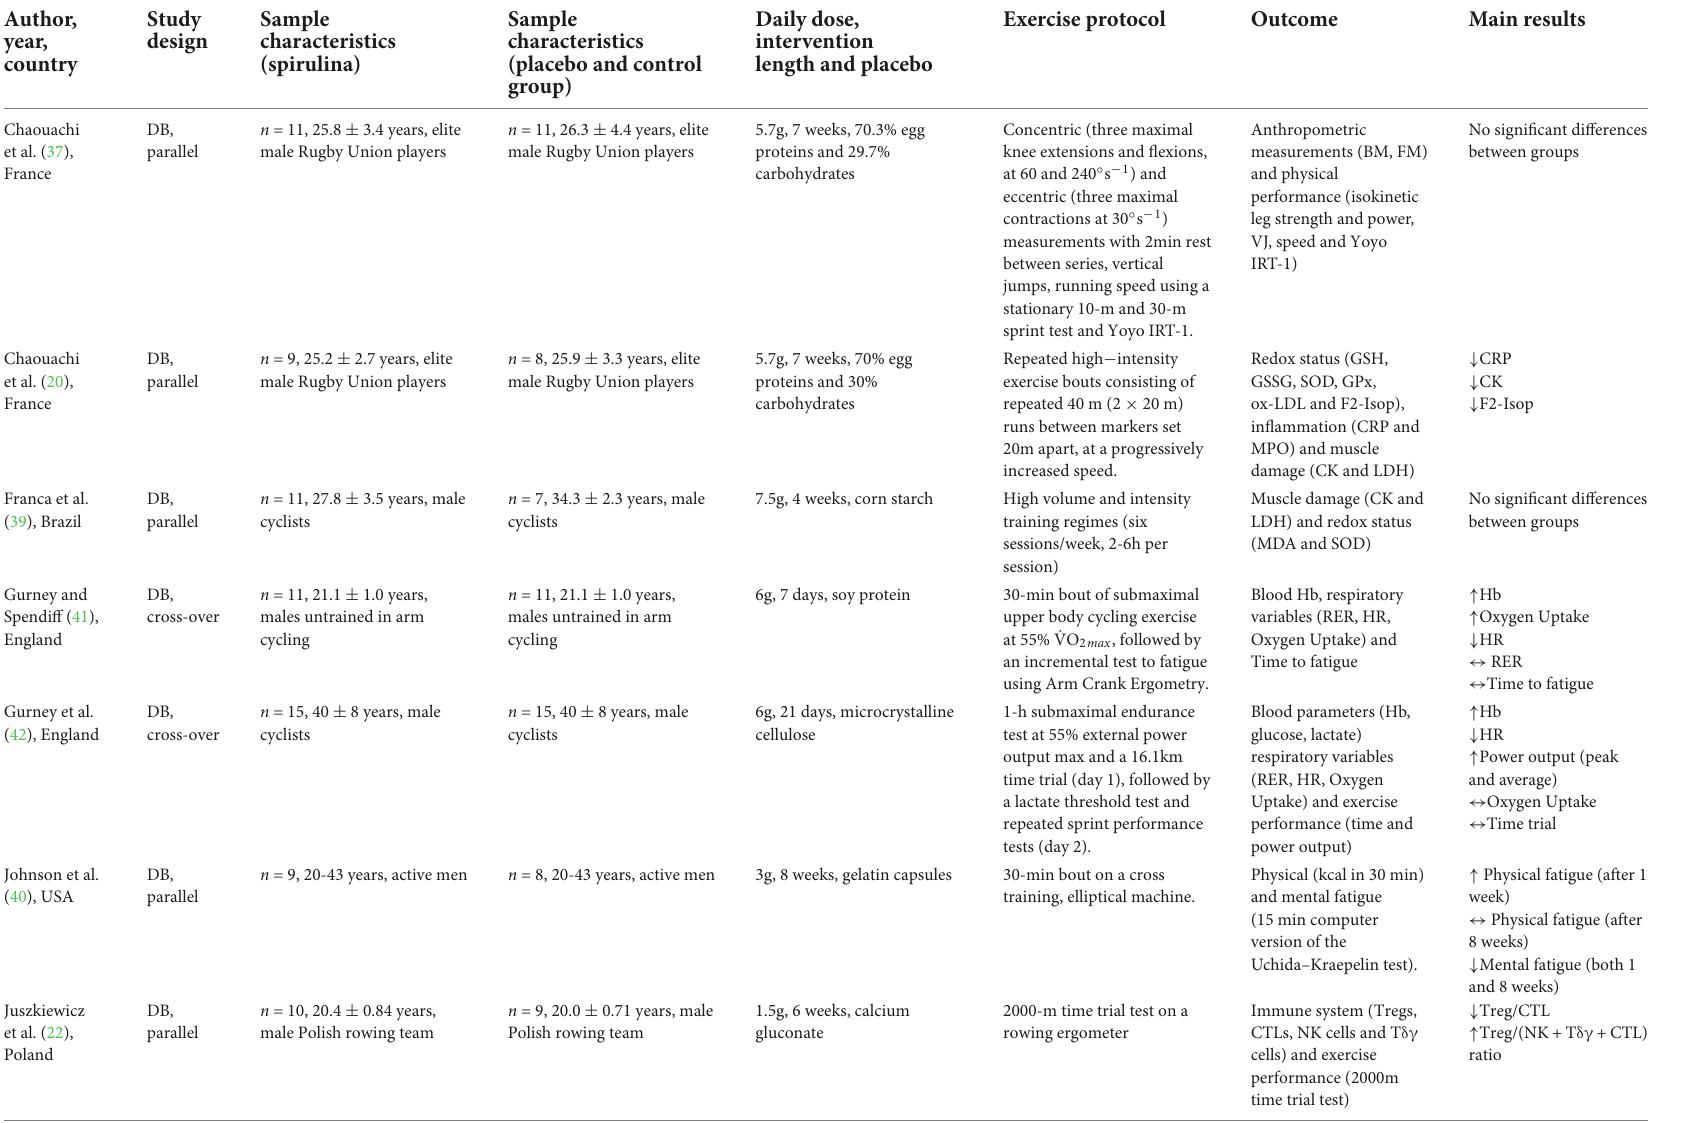
TABLE 1 Sample and intervention characteristics of the